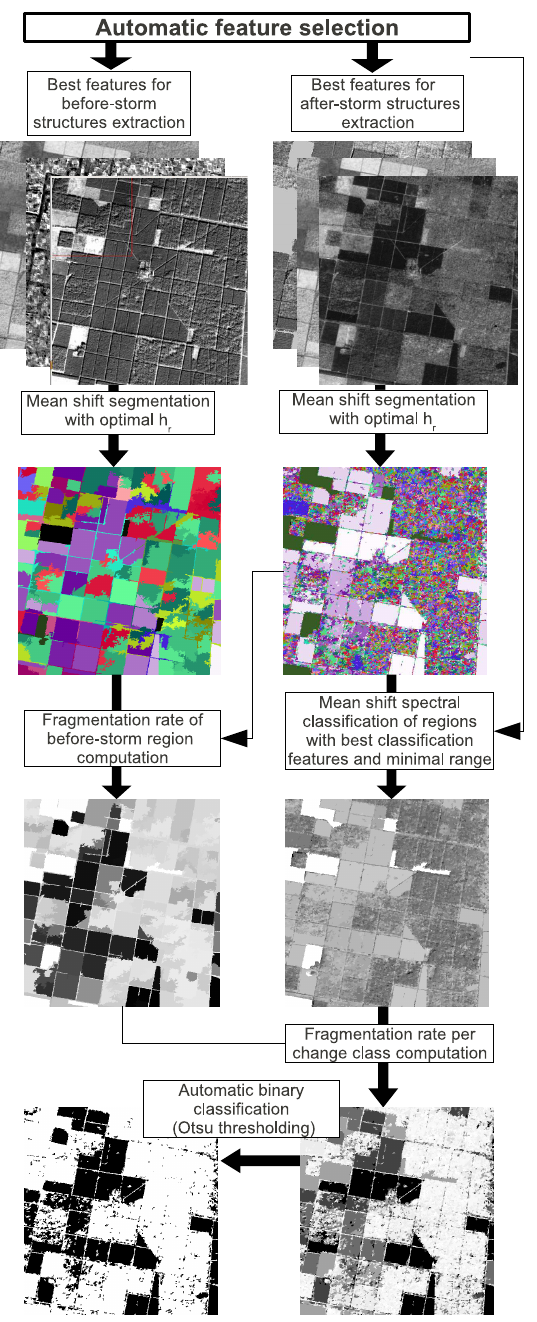
Figure 3: Multitemporal object-based change detection scheme.